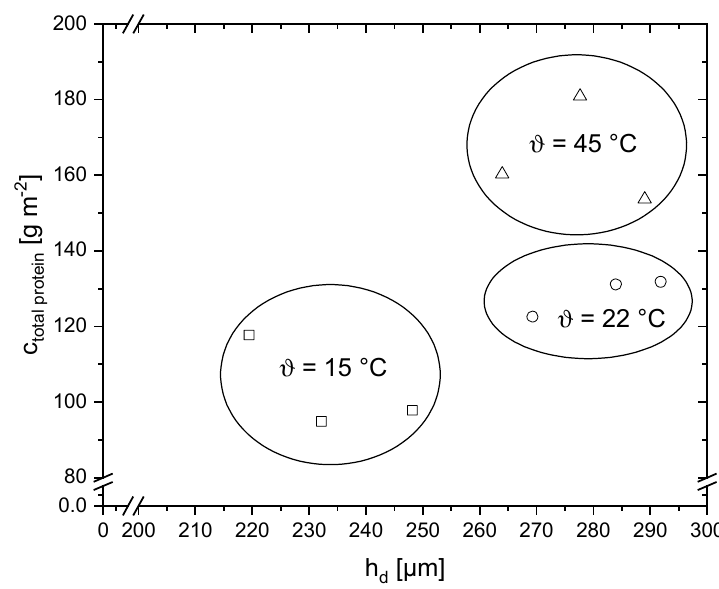
Figure 9. Total protein concentration c total protein measured by RP-HPLC as a function of h d measured by MRI for the three temperatures ϑ = 15 °C (squares), ϑ = 22 °C (circles) and ϑ = 45 °C (triangles).